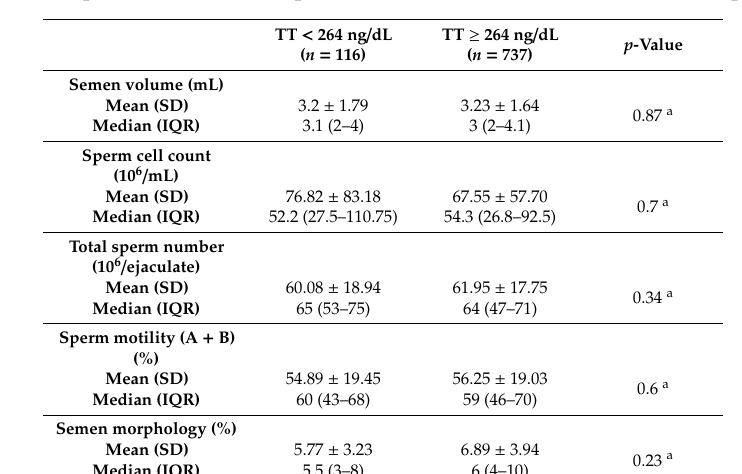
Table 2. Comparison of the semen parameters between low TT and normal TT